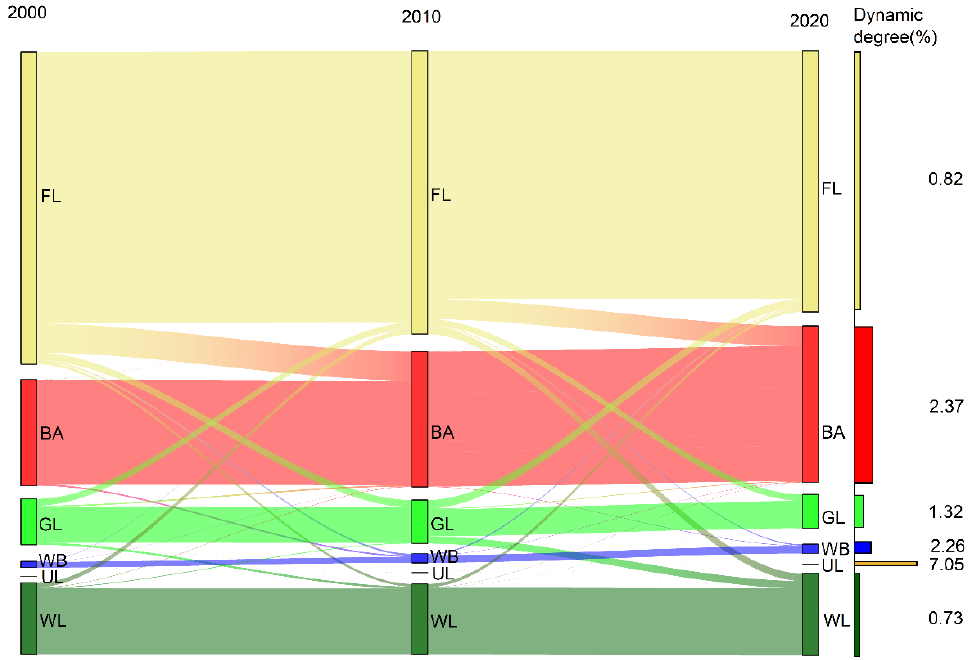
Figure 4. Transfer flow and dynamic degree of land use/land cover in Jinan. Yellow denotes farmland, red denotes built-up areas, light green denotes grassland, blue denotes water body, brown denotes unutilized land, and dark green denotes woodland.